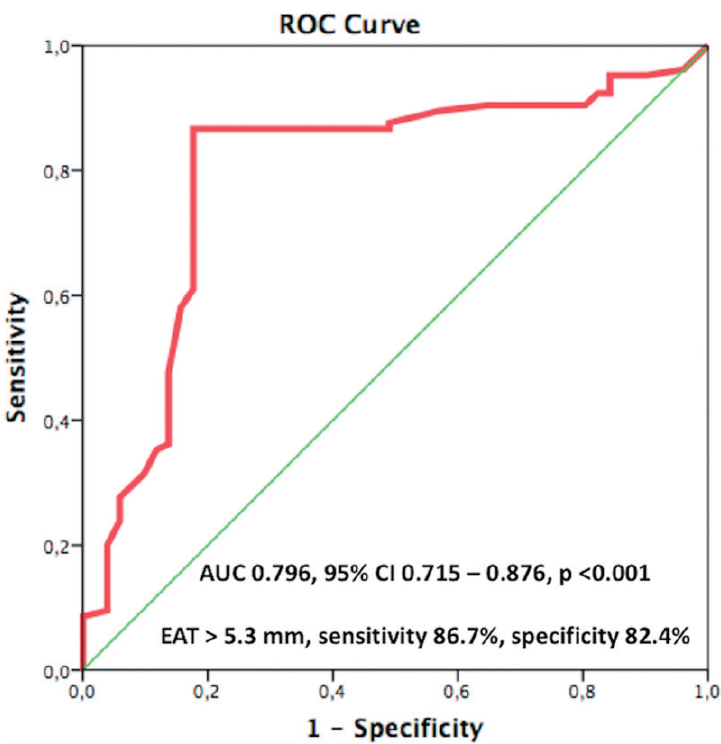
Fig. 2. The ROC curve analysis in prediction of high thrombus burden for EAT